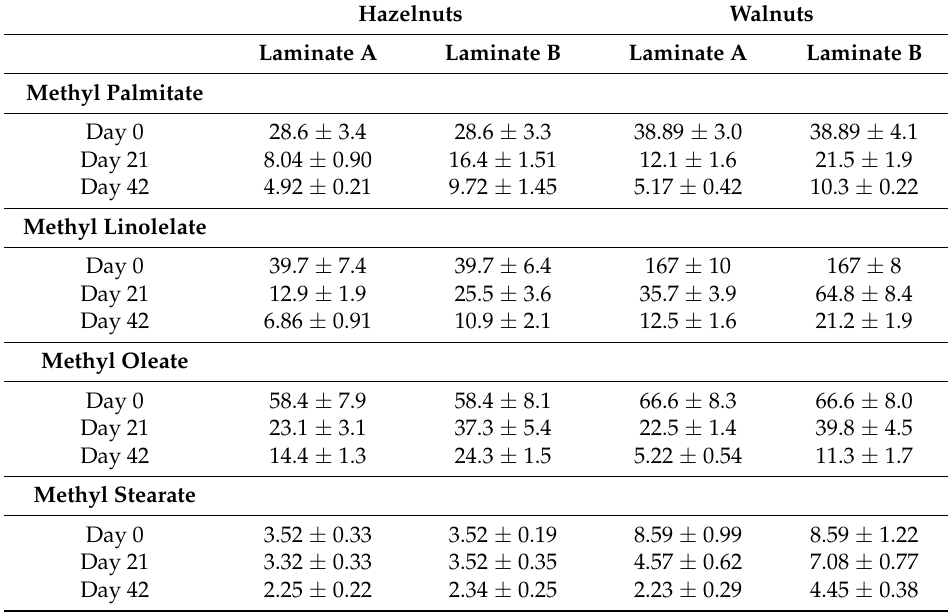
Table 1. Concentration of fatty acids expressed as ng/g of hazelnuts and walnuts obtained for the laminates A (control, without nanoselenium particles) and laminates B (with nanoselenium particles) expressed as ng/g food